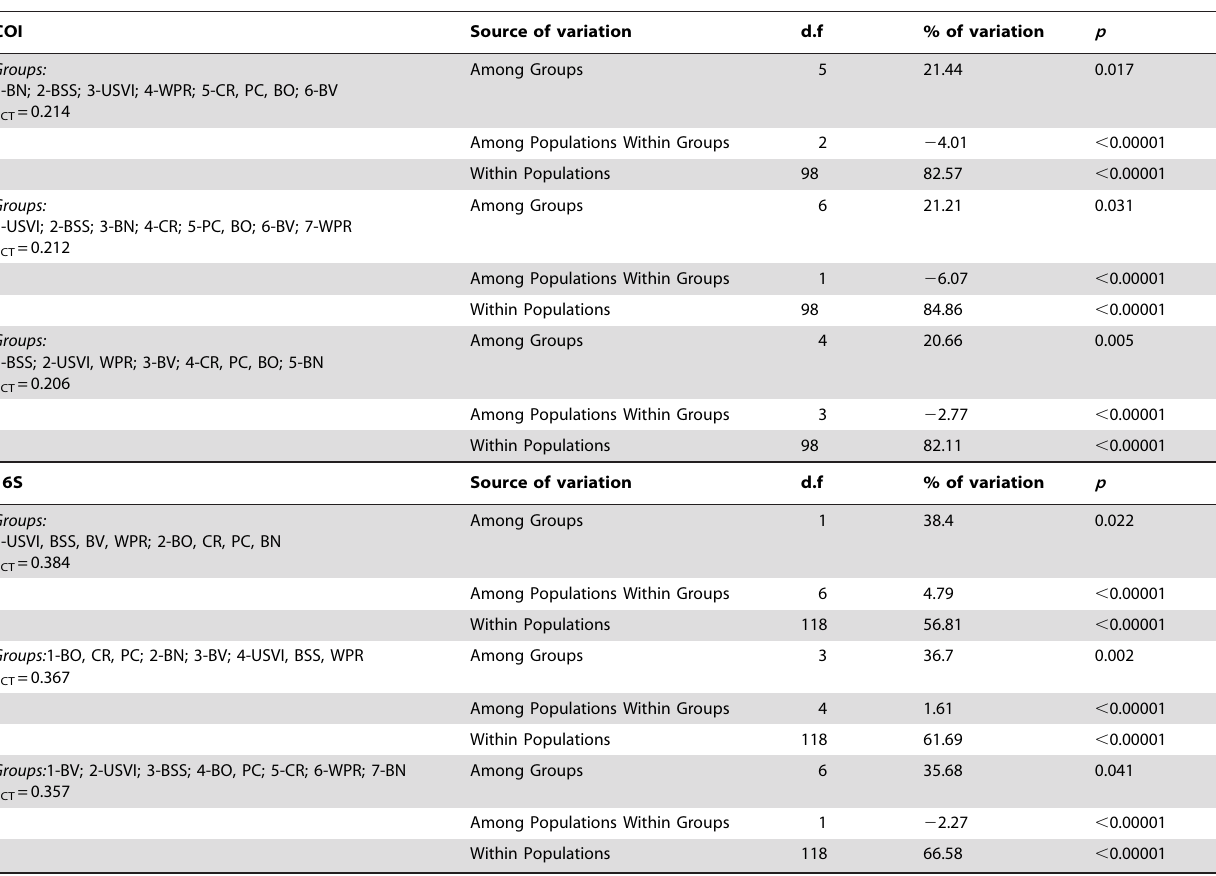
Table 3. SAMOVA results for COI and 16S.